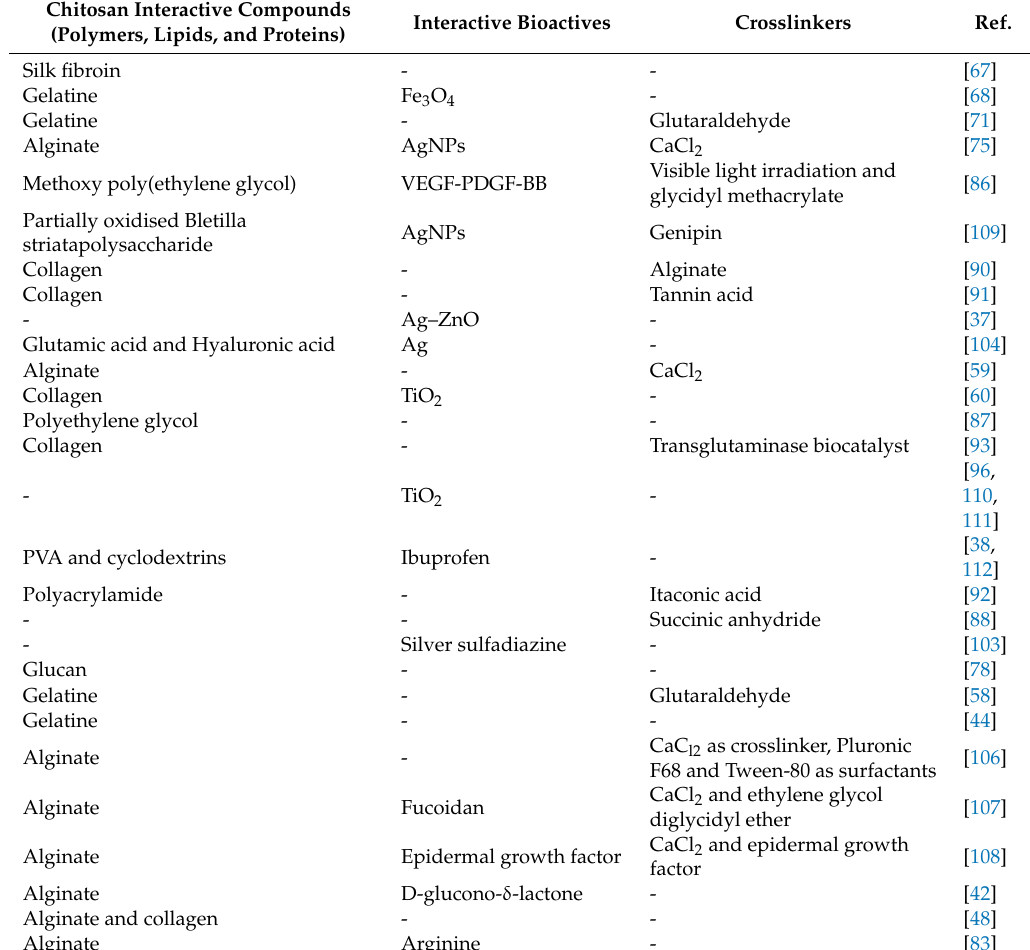
Table 2. Chitosan interactive compounds: polymers; bioactives; and crosslinkers. Chitosan Interactive Compounds (Polymers, Lipids, and